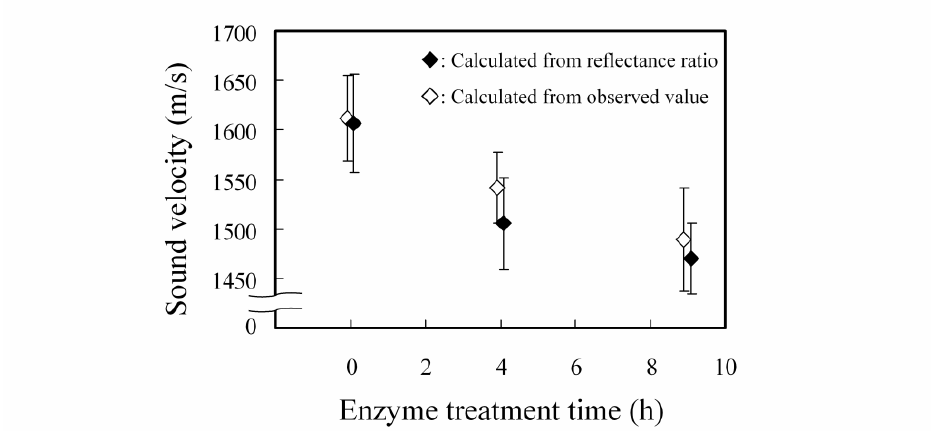
Fig. 5 Changes in sound velocity calculated from equation (2) and from cartilage thickness measured with needle method and echo interval time before (0 h), after 4 hours (4 h), and after 9 hours (9 h) of collagenase digestion. Mean values (SD) are shown for the 0 h (n=10), 4 h (n=10), and 9 h (n=10) groups.